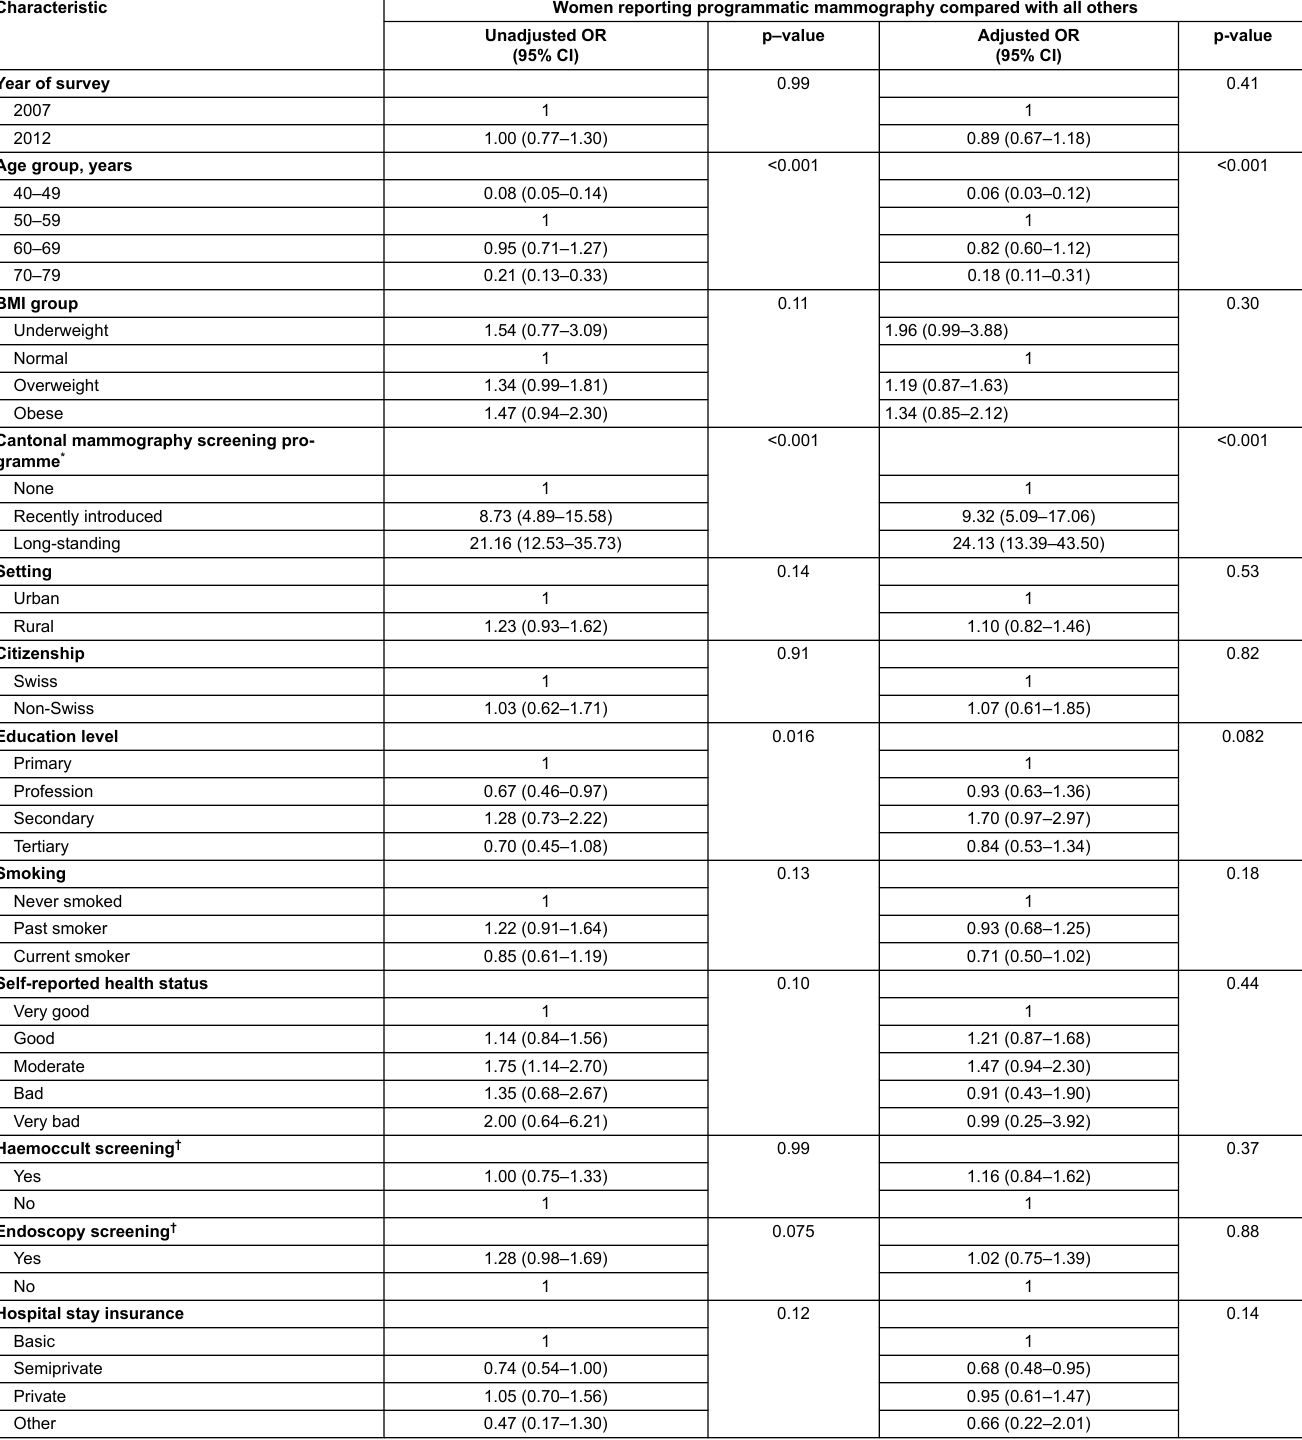
Table S2: Associations of programmatic mammography (within a systematic screening programme) with sociodemographic characteristics and health-related factors compared with all other women aged 40–79 years in Switzerland, 2007 and